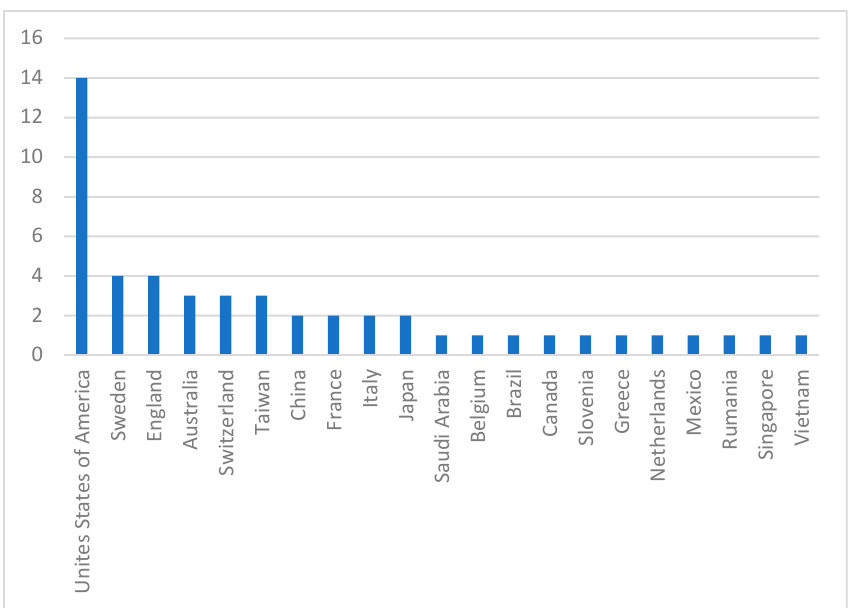
Figure 2. Nations that promote research on technology transfer in offset policies. Source: Research Data.